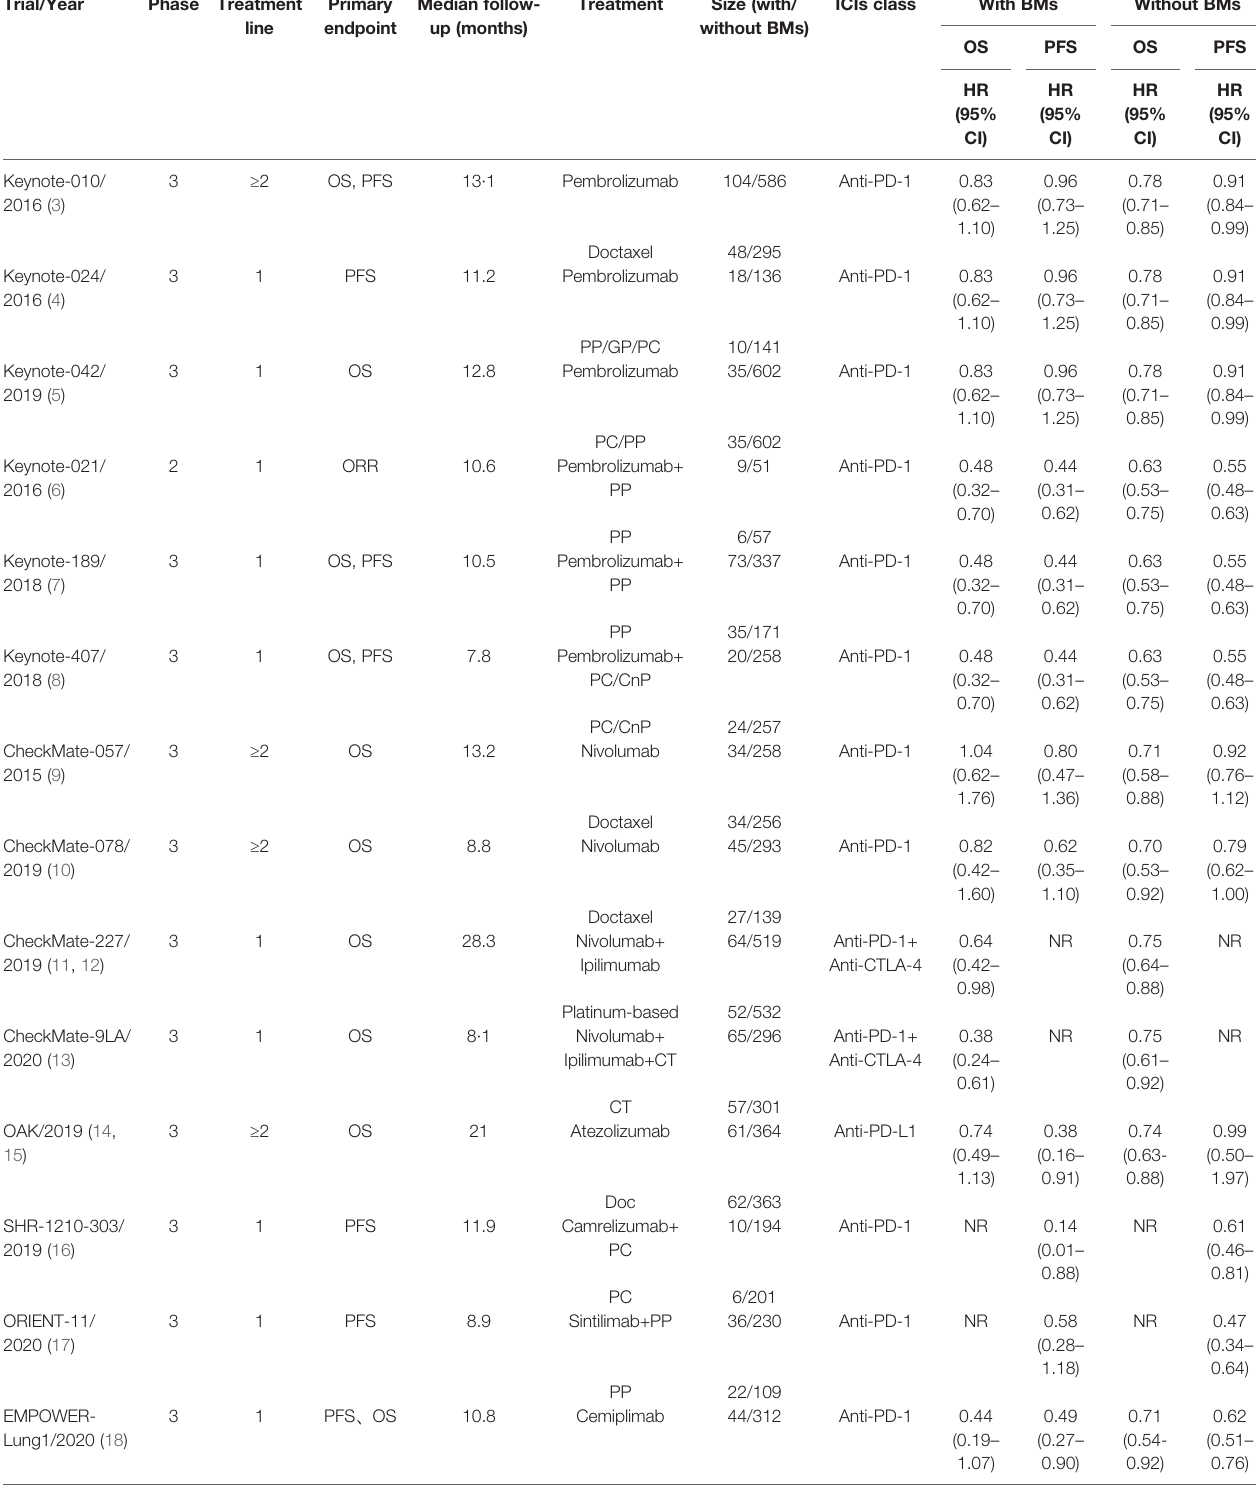
TABLE 1 | Clinical characteristics of included